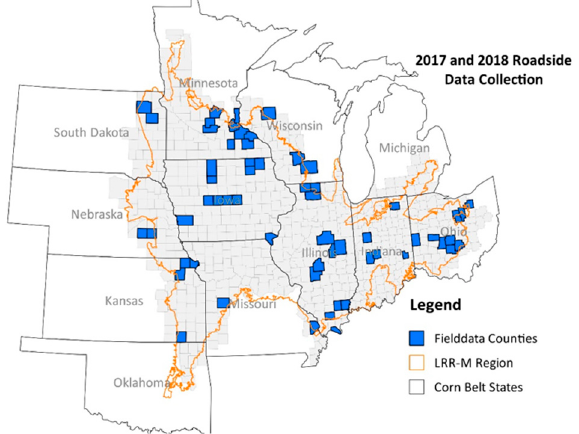
Figure 2. A total of 59 counties were surveyed (blue), and 30 counties were used in verification for the Land Resources Region-M (LRR-M) region (orange line) in 2017 Fall (278 fields) and 2018 Spring (1,195 fields).